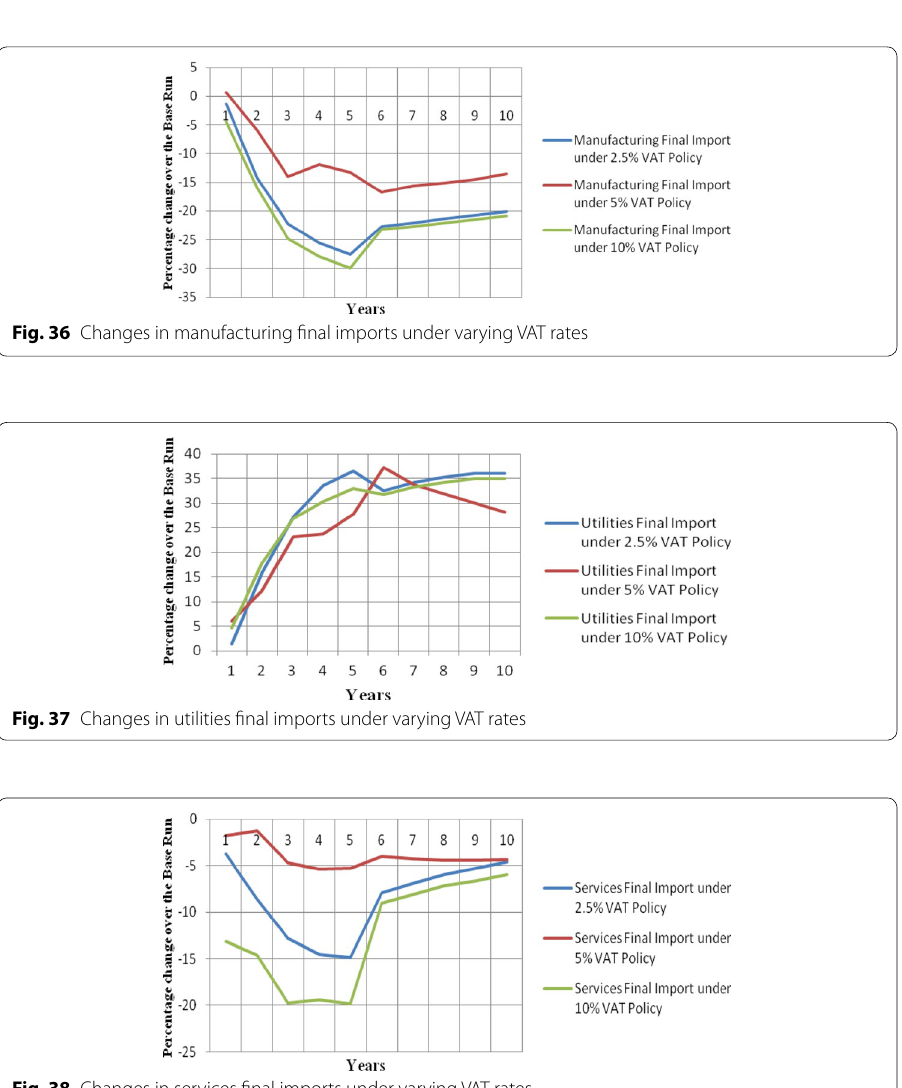
Fig. 38 Changes in services final imports under varying VAT